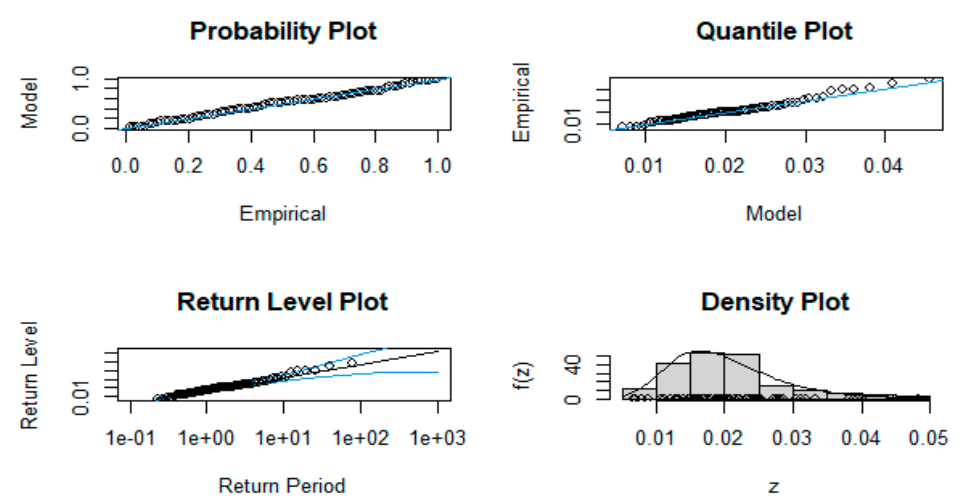
Figure 6. Model diagnostics for the maxima of the ZAR/USD (upper tail, gains or maxima returns).